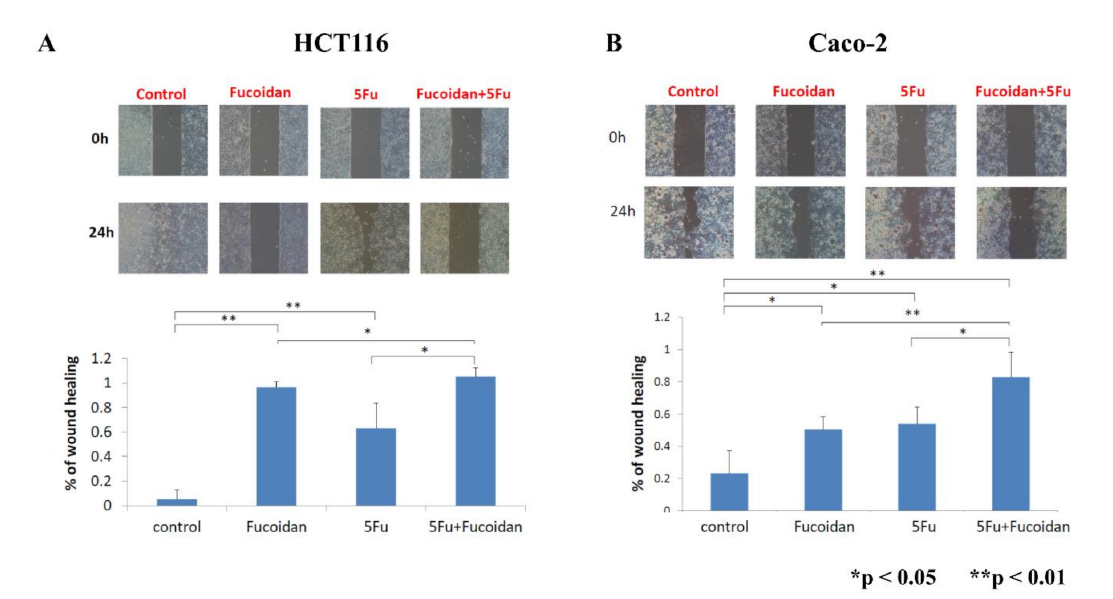
Figure 6. Migration of colon cancer cells after treatment with LMWF, 5-FU, and combination of LMEF and 5-FU: ( A ) HCT116 cells; ( B ) Caco-2 cells. * p < 0.05; ** p <